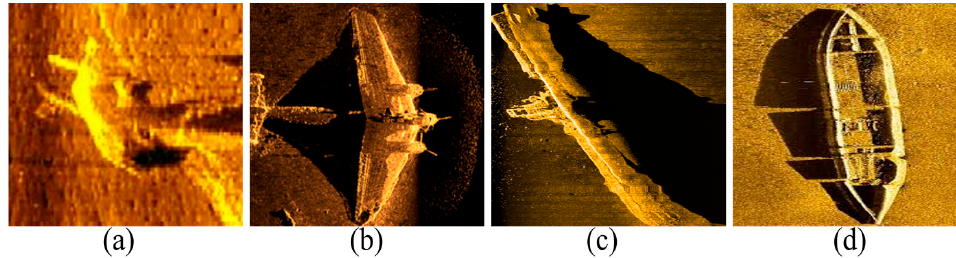
Figure 3. Real sonar images ( a ) Airplane with incline pose. ( b ) Airplane right pose. ( c ) Shipwreck with lateral pose. ( d ) Shipwreck with frontage pose.